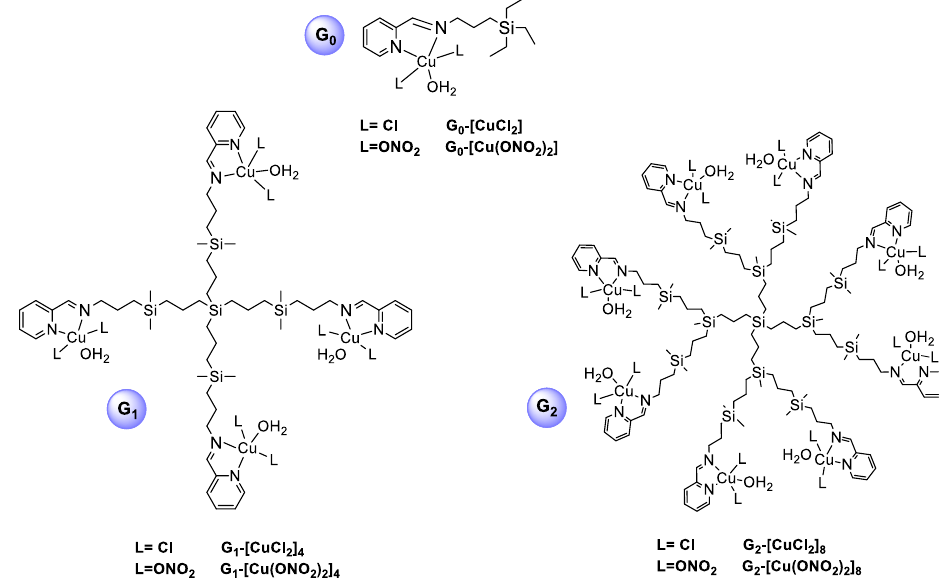
Figure 1. Chemical representation and nomenclature to the Schiff-base copper (II) metallodendrimers of zero (G 0 ), first (G 1 ) and second (G 2 ) generation.